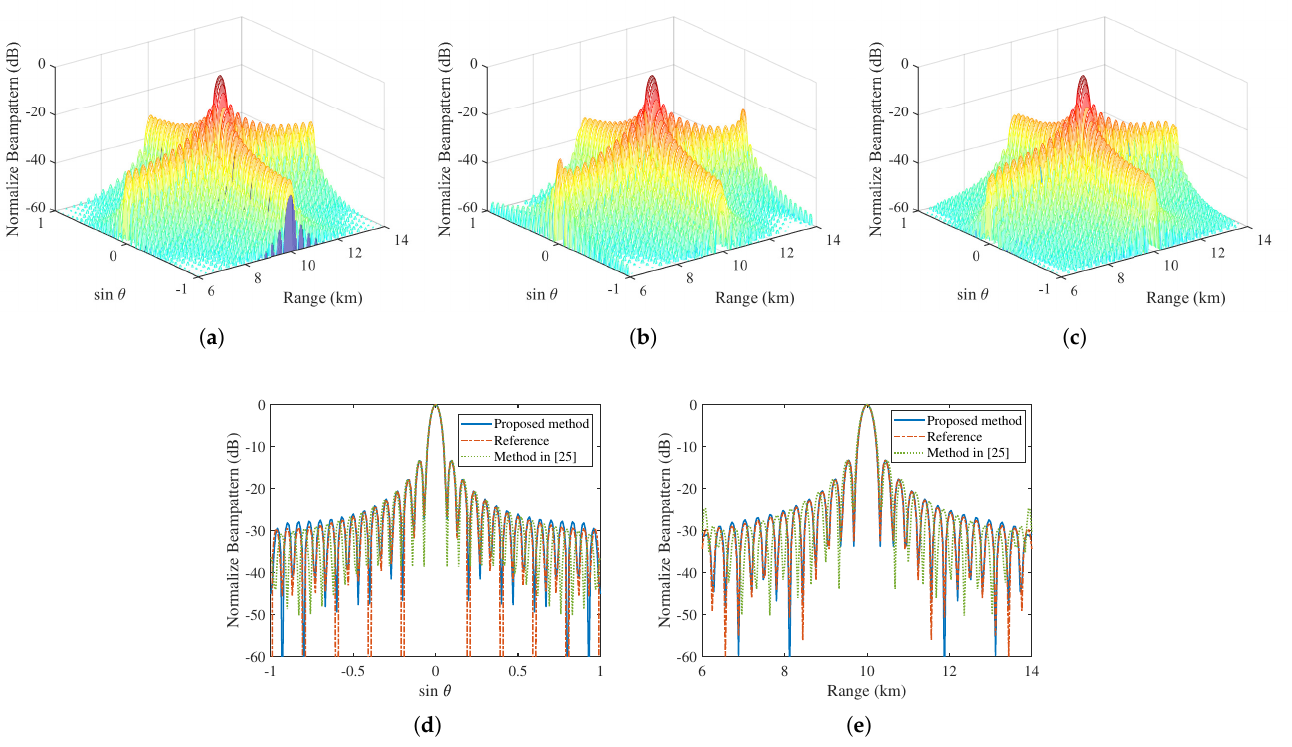
Figure 6. The comparison between the reconstructed pattern and reference pattern. ( a ) The 3D reference pattern. ( b ) The 3D reconstructed pattern obtained by using the method in [25]. ( c ) The 3D reconstructed pattern obtained by using proposed method. ( d ) The cross section of the pattern along angle dimension. ( e ) The cross section of the pattern along range